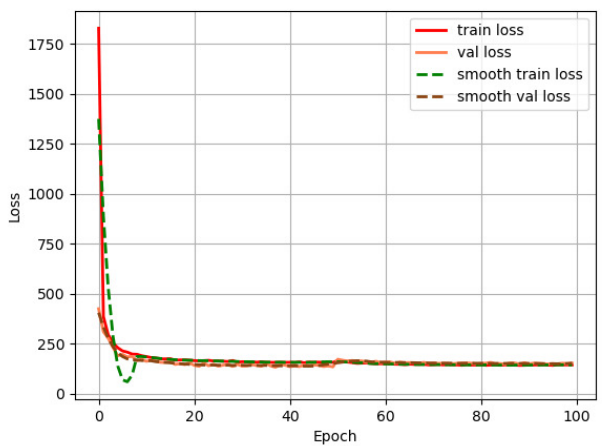
Figure 10. Loss curve of YOLOv3 training